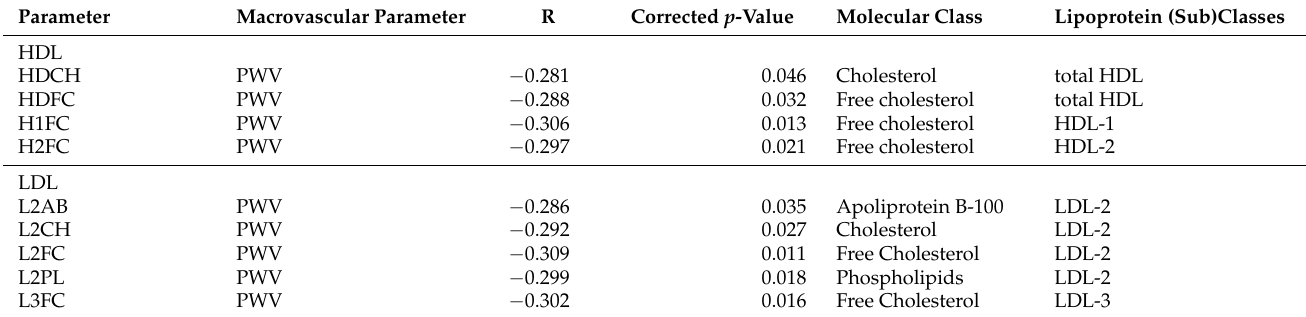
Table 3. Associations of lipoprotein subclasses and macrovascular health.